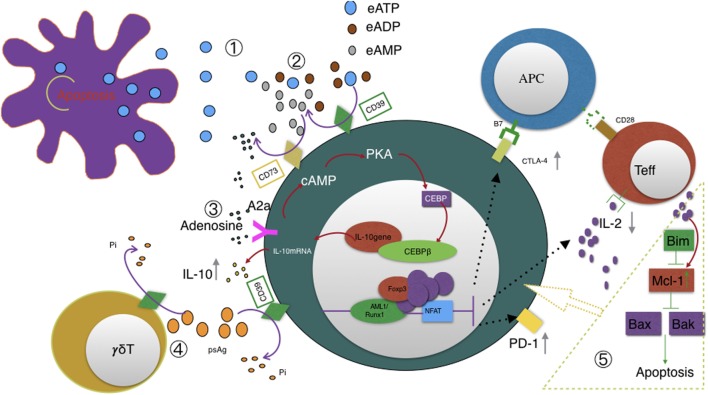
Illustration of CD39 function ① eATP accumulates in the extracellular space in response to metabolic stress or cell damage such as apoptosis. ② CD39 initiates extracellular adenosine generation by catalyzing the degradation of ATP and ADP to AMP; CD73 also has ecto-5′-nucleotidase enzyme activity that catalyzes the dephosphorylation of AMP to adenosine; CD39, not CD73, is the rate-limiting enzyme of the cascade leading to the generation of suppressive adenosine. ③ Adenosine activates A2A receptor and subsequently triggers pathways converge on CEBPβ to induce IL10 production. ④ CD39 also dephosphorylates pAgs of Vγ9Vδ2 T cells. This degradation may also be catalyzed by CD39 expressed on Tregs and possibly represents a novel mechanism of Tregs suppressing Vγ9Vδ2 T cells. CD39 upregulation acts as a feedback mechanism to desensitize Vγ9Vδ2 T cells to self- and pathogen-associated pAgs. ⑤ Pro-apoptotic Bim, antiapoptotic Mcl-1, and apoptotic regulators Bax and Bak altogether contribute to T cells homeostasis and survival. Especially, IL-2 and costimulatory signals upregulate Mcl-1 expression and hence allows Tregs to proliferate. We speculate that CD39 is involved in the above signal transduction since CD39 were reported to be associated with T cells apoptosis.